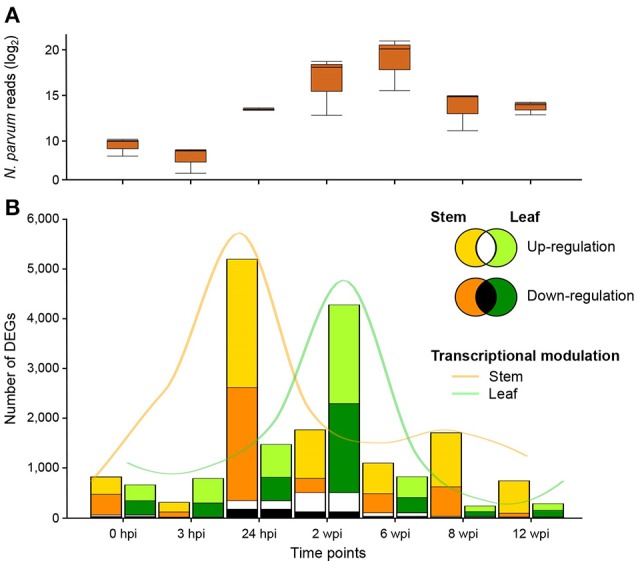
Differentially expressed genes (DEGs) during N. parvum infection. (A) Number of reads (log2) mapped on N. parvum transcriptome during the time course of fungal colonization. (B) Number of grape genes up- and down-regulated in stem (gold and orange, respectively) and leaf (light and dark green, respectively) tissues during N. parvum infection. Number of genes commonly up- and down-regulated in the two organs at each time point are represented in white and black color, respectively.